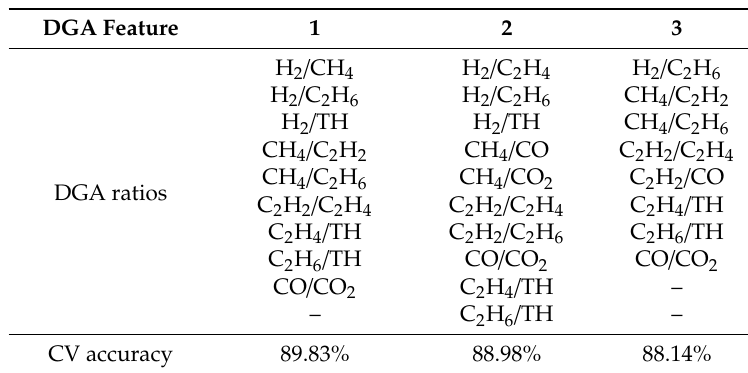
Table 6. Best three sets of DGA feature.